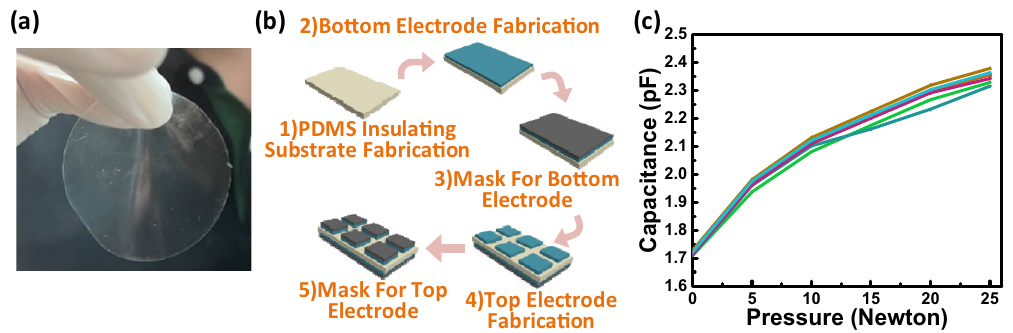
Figure 2. ( a ) Photograph of the standalone PDMS layer; ( b ) process flow of fabrication of the flexible E-skin; and ( c ) a typical relationship between the applied pressure and capacitance for a capacitive sensor.